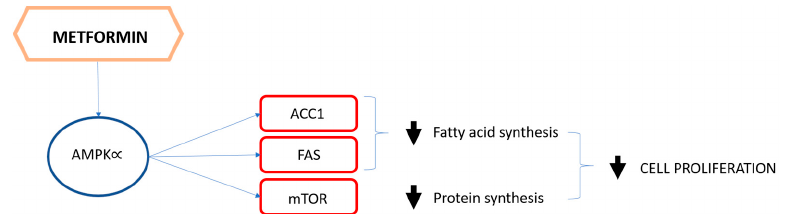
Figure 1. The pathway that corroborates the hypothesis of the direct effect of metformin on tumor cell proliferation.